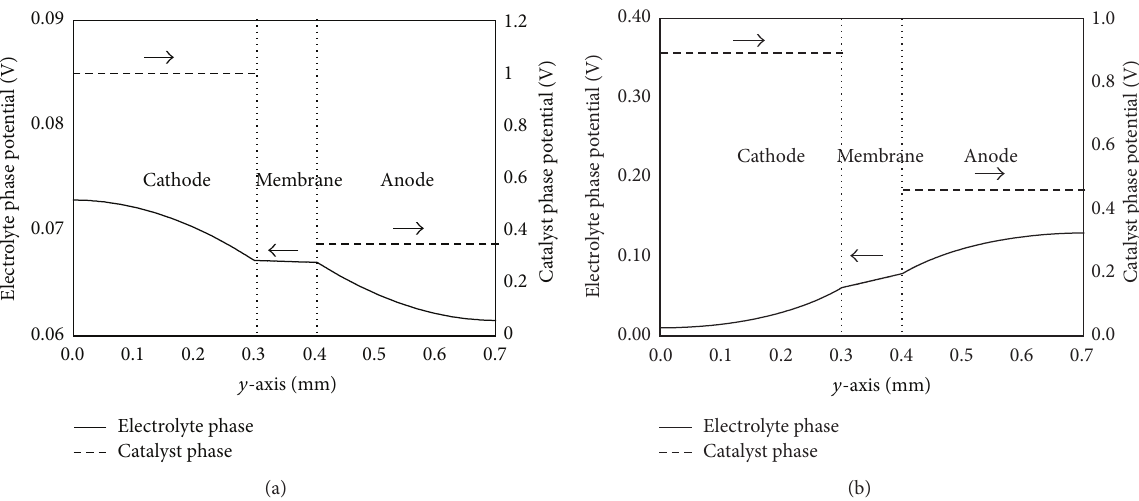
Figure 7: Electrical potential profiles in the 𝑦 -direction for the electrolyte and catalyst phases located at the middle of the domain 𝑥 -direction for the cathode and anode catalyst layers and membrane layer. The arrows point in the direction of the ordinate scale that applies to each of the three curves. (a) Proton migration plus diffusion within the electrolyte phase (the present model) (b) Proton migration only within the electrolyte phase [5].